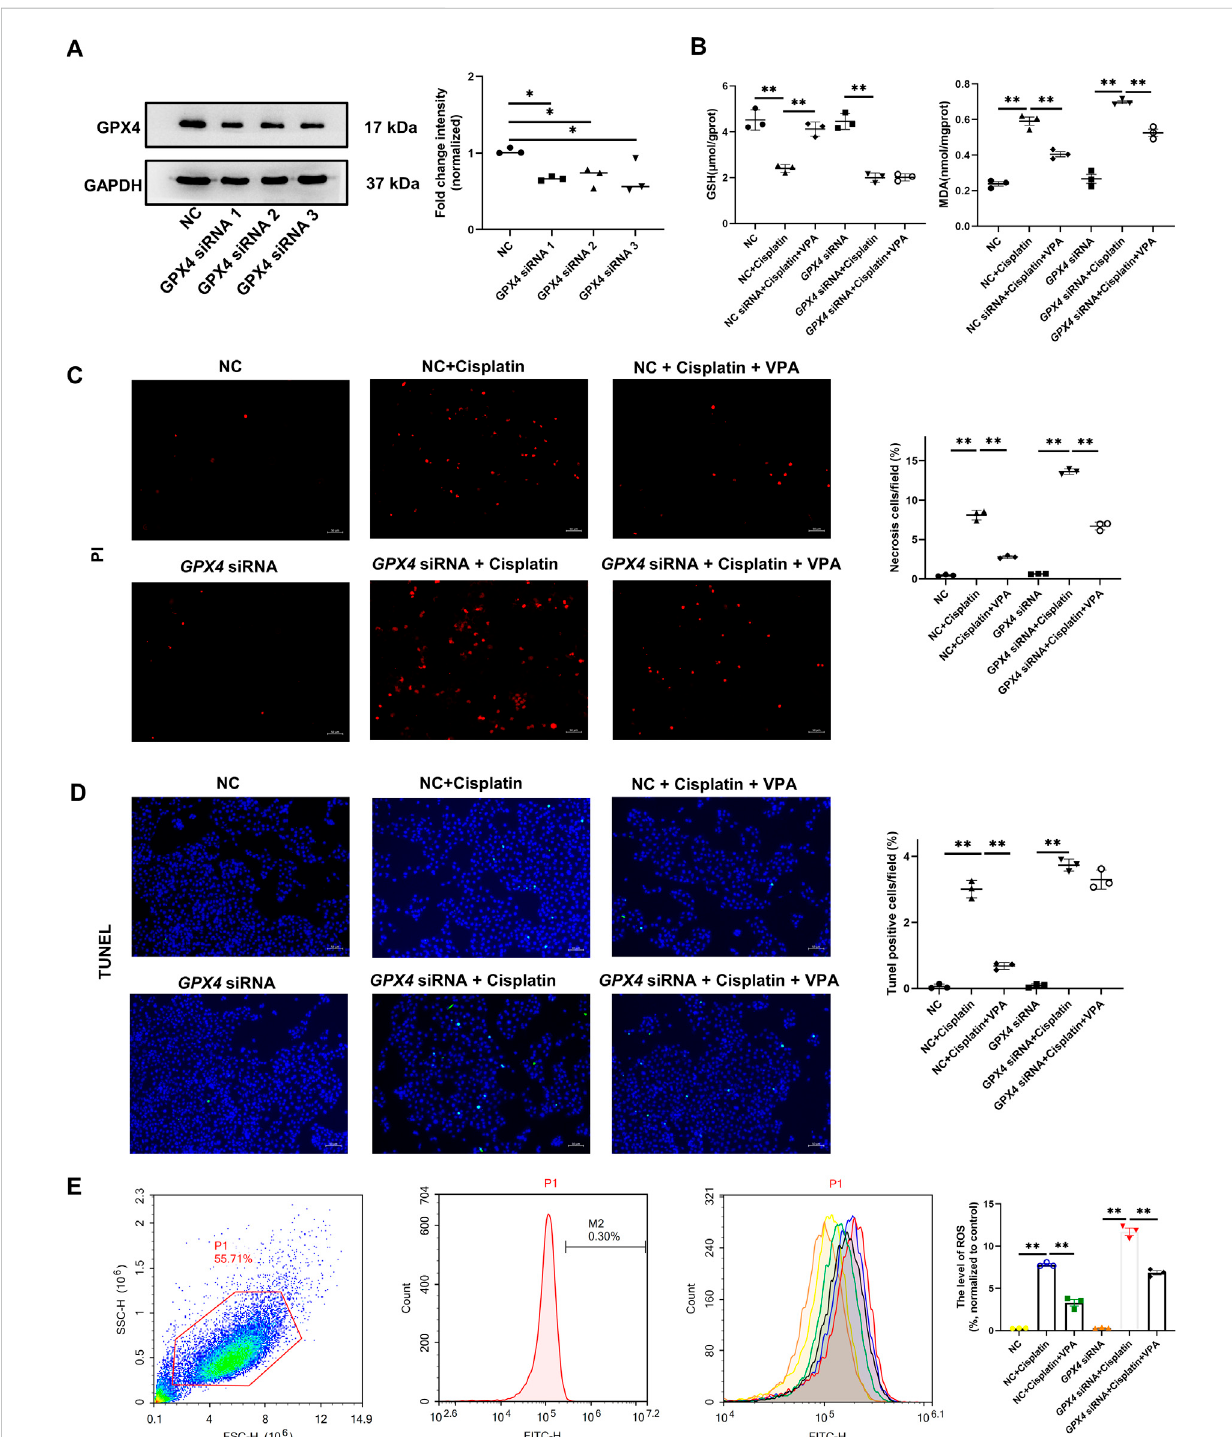
FIGURE 6 TheprotectiveeffectofVPAisweakenedbyGPX4de fi ciency.RepresentativeimagesofWesternblotandquanti fi cationofthelevelofGPX4inHK-2 cells (A) . The production of GSH and MDA in cisplatin-stimulated HK-2 cells with GPX4 siRNA (B) . PI staining (red) and statistical analysis of cell death in eachgroup inHK-2 cells. Scalebar =50 μ m (C) .TUNEL fl uorescence stainingand statistical analysisofapoptosis cellsineach groupinHK-2 cells. Green fl uorescenceinpicturesrepresentpositivesignalsofapoptosiscells,whileblue fl uorescencerepresentsnuclearstaining,Scalebar=50 μ m (D) .The production of ROS was detected by ROS assay kit and was present as FITC-H value in P1 region (E) . ✱✱ value p < 0.01, ✱ value p < 0.05. Statistically analyzed via a one-way